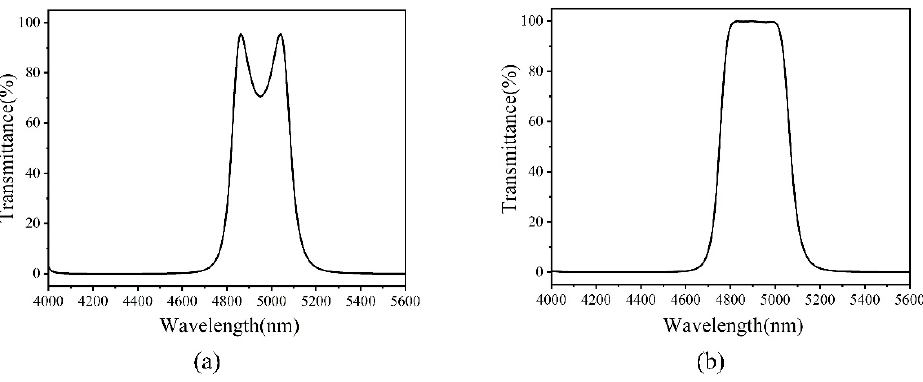
Figure 4. ( a ) Calculated transmittance of bandpass filter for the region 4.85–4.95 µ m with the primary structure. The substrate is double-polished silicon (n = 3.5); H = germanium (n = 4.0), L = zinc sulfide (n = 2.35) and the incident medium is air (n = 1.0). ( b ) Calculated transmittance of bandpass filter for the region 4.85–4.95 µ m with the optimized structure.